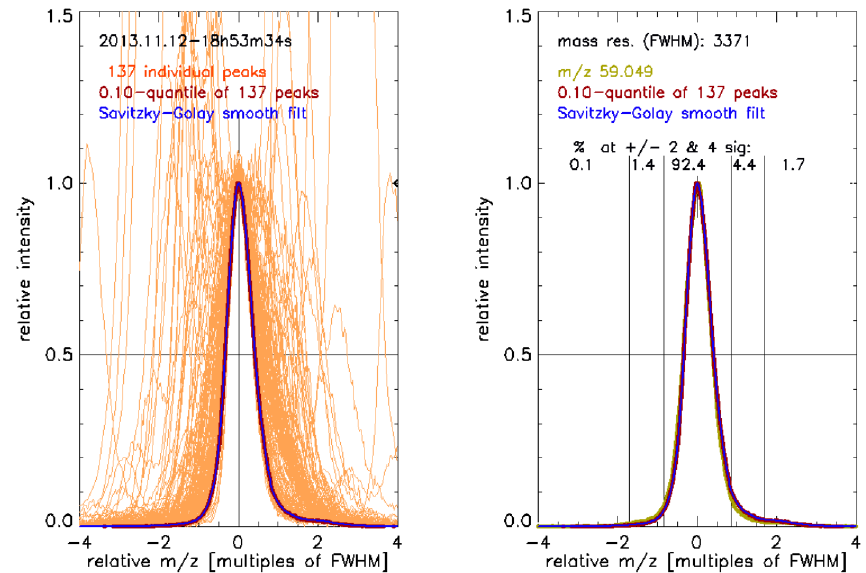
Figure 4. The left hand chart shows 137 normalized and re-scaled individual peaks retrieved from an example mass spectrum. The individual peaks envelop the true peak shape (blue line) which is retrieved by smoothing the 0.1 percentile of the relative intensity of all 137 peaks (brown line, barely visible because superimposed by the blue line). The right hand chart shows the true peak shape (as in the left hand chart) together with an example peak detected at m/z 59 . 049. The calculated mass resolution (FWHM) and the signal fractions expected within and outside the ± 2 and ± 4 σ boundaries are labeled in the plot area. 92.4% of the total signal is expected within the ± 2 σ boundary. A small shoulder is apparent at the high mass end, and therefore 1.7% of the signal are detected outside the + 4 σ